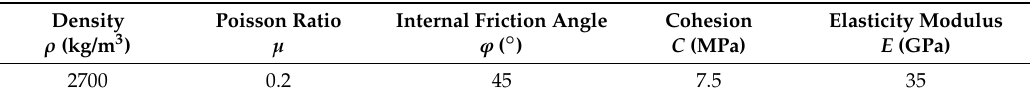
Figure 17. Three-dimensional numerical model: ( a ) Diversion tunnel; ( b ) Cross passage; ( c ) Auxiliary tunnel. Table 3. Mechanical parameters of surrounding Table 3. Mechanical parameters of surrounding rock.